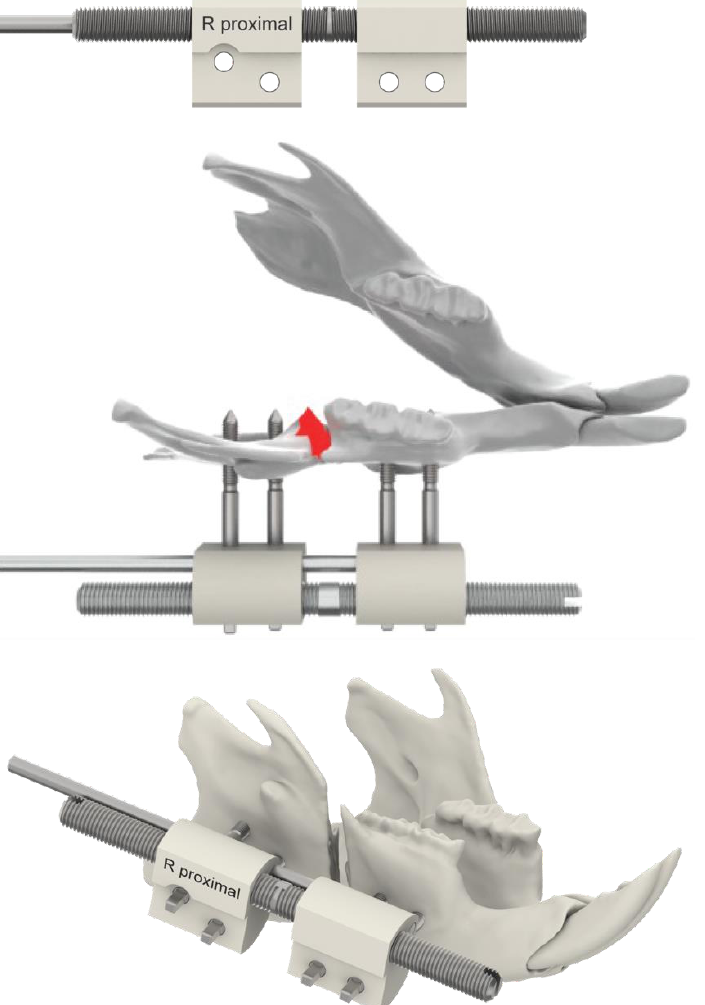
Figure 2. Extraoral distraction osteogenesis device for rat mandible: each of the two PEEK blocks comprises two holes for incorporating the TAN screws to be fixed in the mandible; a supporting rod guides the threaded rod for the adjustment of distraction distance. Details on the device and the surgical procedures can be found in www.risystem.com, accessed on 4 June 2022.